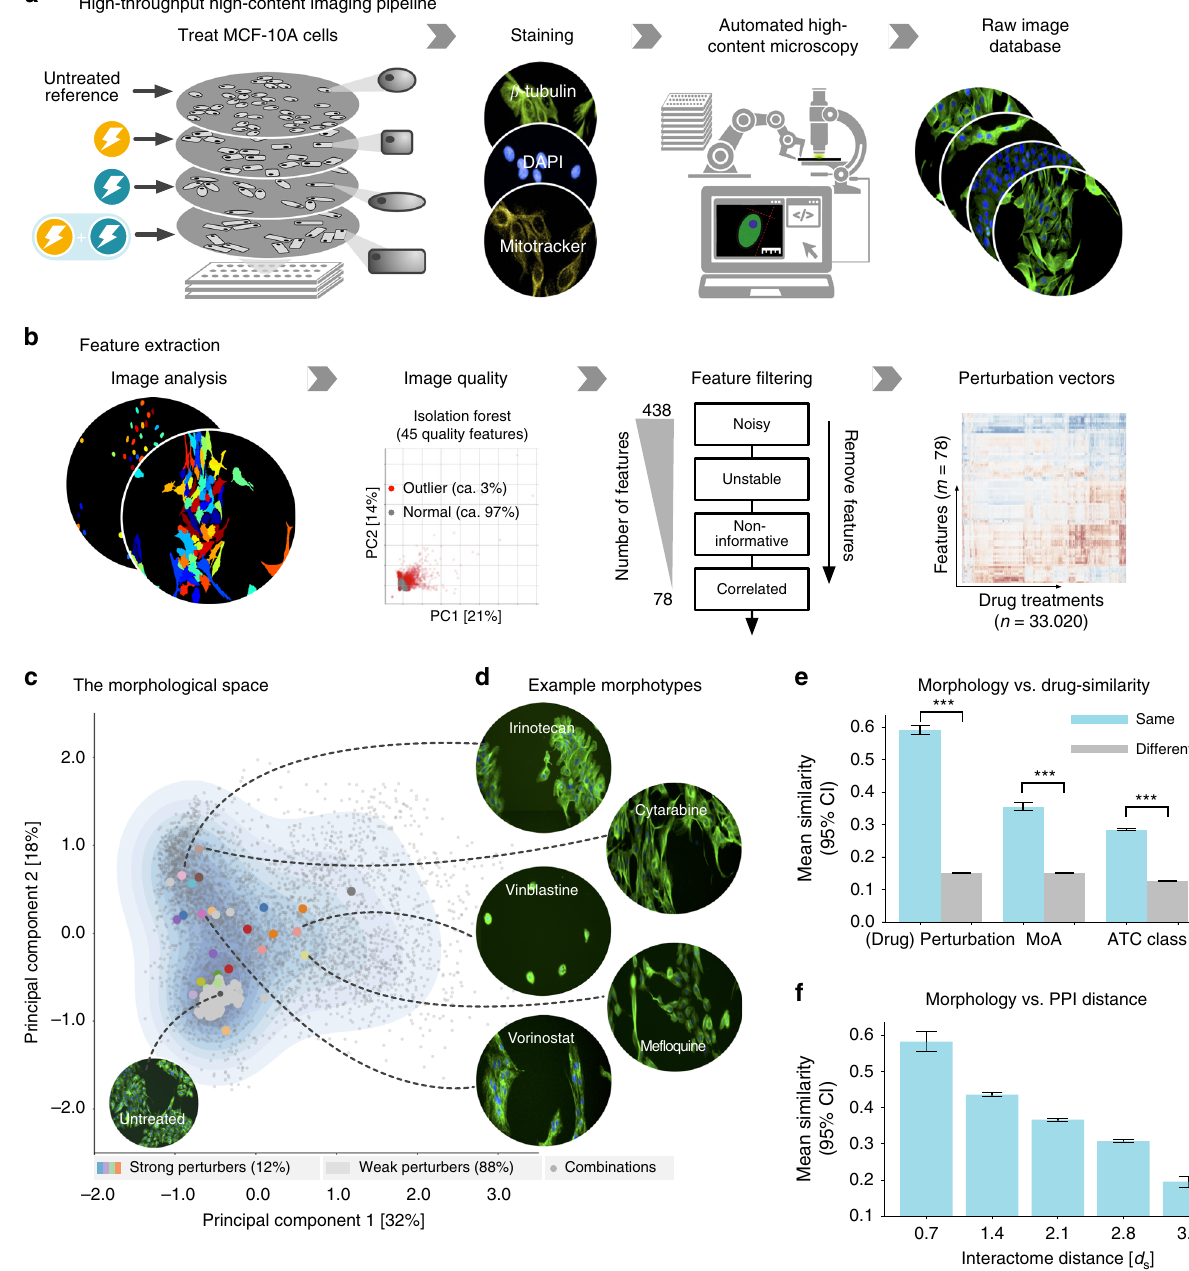
Fig. 3 Imaging screen for identifying cell morphology changes induced by chemical perturbations and their combinations. a Overview of the imaging pipeline. We treated an epithelial MCF-10A cell line with 267 chemical compounds and all 35,511 pairwise combinations. Cells were plated in a 384-well plate, stained for nucleus, cytoskeleton, and mitochondria and imaged using automated high-throughput microscopy at 20× resolution. b Extraction of morphological features: images with technical artifacts are identi fi ed and removed using a machine learning approach. Cells are segmented and features are extracted using the software CellPro fi ler. We remove all features that are too noisy, not robust across replicates, show too little variation or are redundant, resulting in a 78-dimensional feature vector for each treatment. c The 78-dimensional morphological space projected onto its fi rst two principal components. Each dot represents the cell morphology of a speci fi c treatment (DMSO control, single drug, or drug combination). d Example images of drugs resulting in a strong morphological phenotype. e Evaluation of the morphological similarity for replicates of the same drug, drugs with the same mechanism of action (MOA) and drugs of the same therapeutic ATC class (*** denotes P value < 0.001, Mann – Whitney U test). f Morphological similarity versus interactome distance of the respective drug targets. The closer the targets of two drugs are on the interactome, the more similar are the morphological changes they induce in our cell line. Bars in e , f indicate the mean over all measurements; error bars show the 95% con fi dence